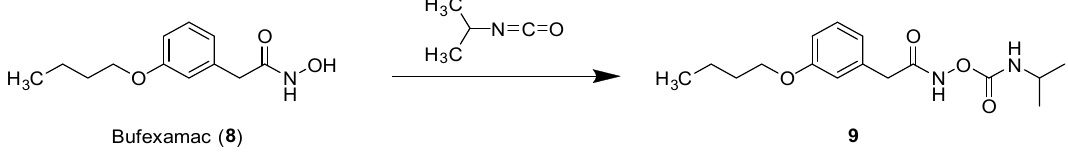
Scheme 3. Route of synthesis for the carbamate derived from bufexamac. Reaction conditions : dimethylformamide, acetone, − 15 °C.